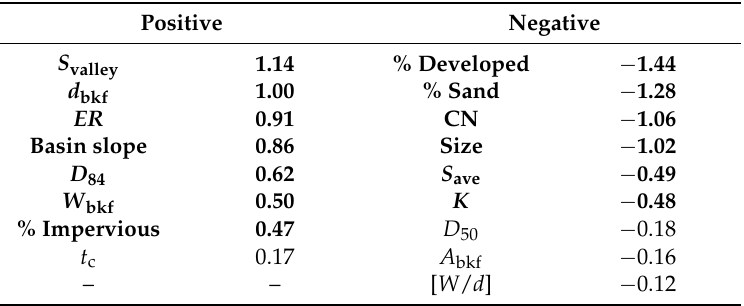
Table 7. Coefficients or weights for each morphology and watershed factor resulting from ridge regression. Variables with higher weights are in